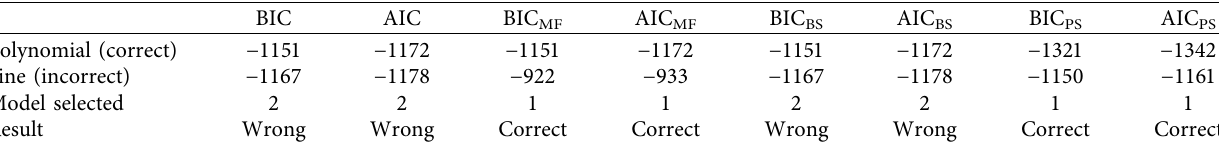
Table 1: Estimates of the various versions of the indicator for the problematic examples of the comparison between a polynomial (model 1) and a sinusoid (model 2) introduced in Section